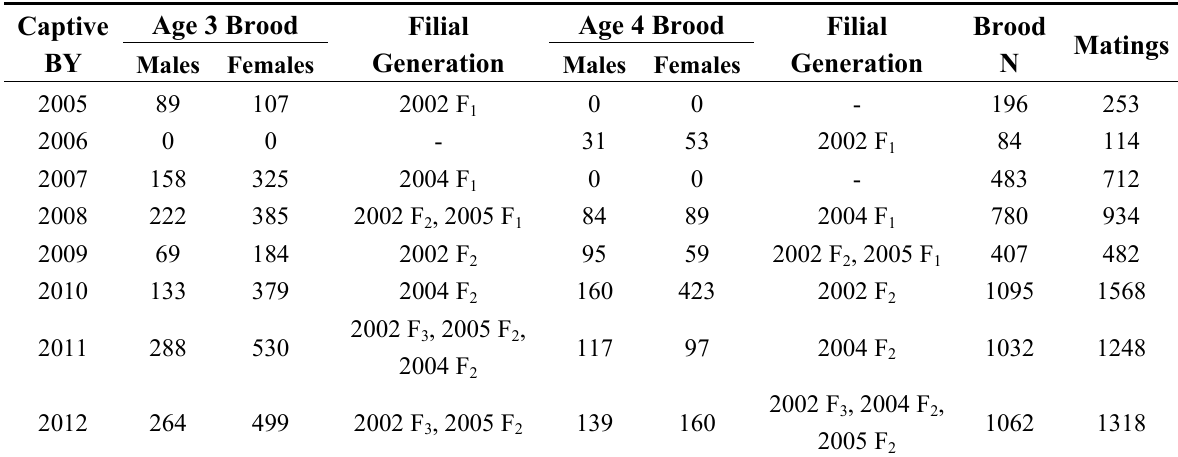
Table 4. Sakinaw Lake sockeye salmon captive brood numbers by age and gender for broodyears (BY) 2005 to 2012 at Rosewall hatchery. Descendants of the three parental founder groups are indicated by filial generation for each age group in each of the captive BYs. In the 2007 BY, four age 5 adults (2002 F ) were also spawned (not shown). 1 Captive